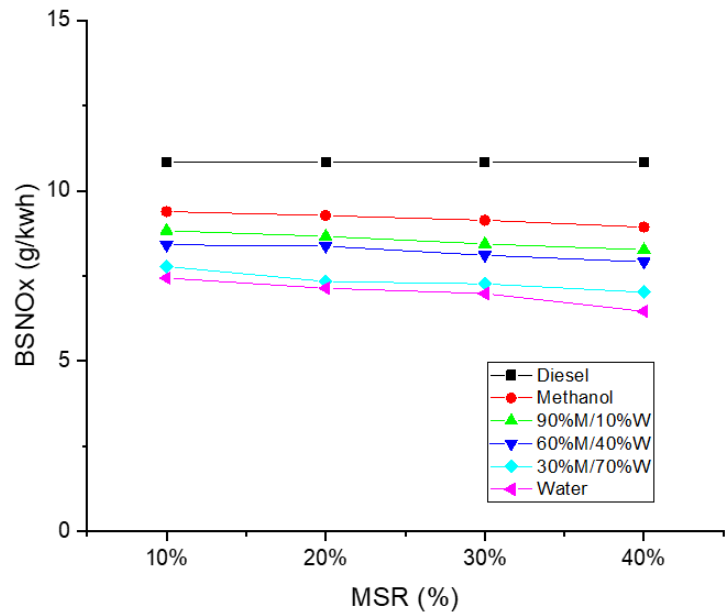
Figure 10. Changes in NOx emissions with different fuel mixture ratios.